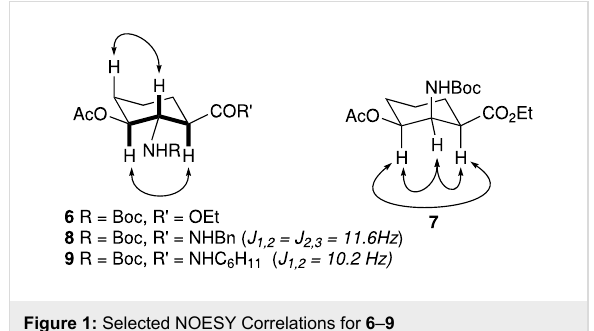
Figure 1: Selected NOESY Correlations for 6 – 9